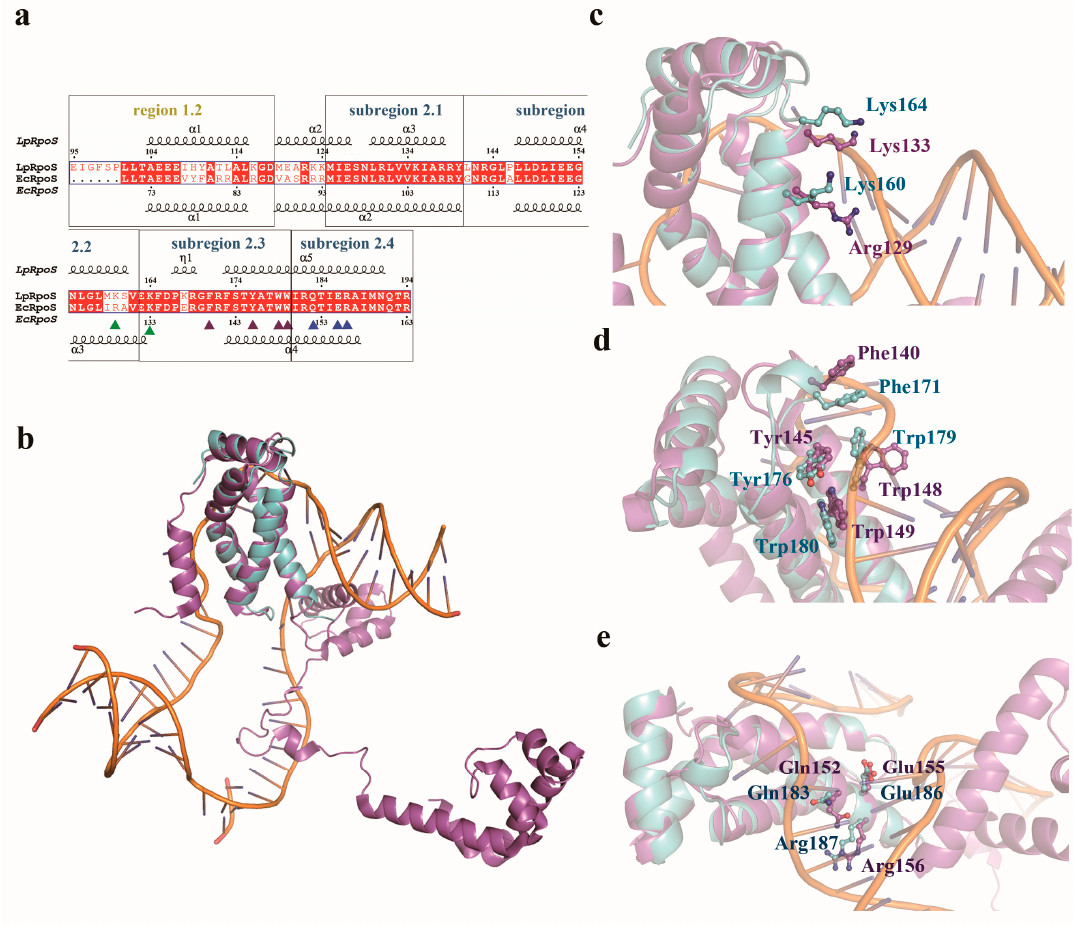
Figure 2. ( a ) Multiple alignment of Lp RpoS 95 – 195 and the corresponding region from Ec RpoS (PDB accession code 5ipl). The alignment is performed using MultAlin [11] and ESPript [12]. The secondary structural elements of Lp HGPRT and human HGPRT are separately displayed at the top and bottom of the alignment. The α -helices, 3 10 –helices, β -sheets and strict β -turns are denoted as α , η , β and TT, correspondingly. The DNA binding site, promoter melting site and the residues involved in recognizing the − 10 promoter element are marked by filled green, purple and blue triangles, respectively. The key residues from Ec RpoS (Asp87, Asp135, Pro136, and Glu137) and the corresponding residues from Lp RpoS 95–195 (Asp118, Asp166, Pro167 and Lys168) are marked in pink. ( b ) Superposition of Lp RpoS 95–195 (cyan) and full-length Ec RpoS complexed with DNA (purple) (PDB accession code 5ipl). DNA is marked in orange. ( c ) Comparison of Lp RpoS 95–195 (cyan) and Ec RpoS (purple) (PDB accession code 5ipl) structures in DNA binding site. The residues, which are involved in DNA binding site, are shown in stick form. ( d ) Comparison of Lp RpoS 95–195 (cyan) and Ec RpoS (purple) (PDB accession code 5ipl) structures in promoter melting site. The residues, which are involved in promoter melting site, are shown in stick form. ( e ) Comparison of Lp RpoS 95–195 (cyan) and Ec RpoS (purple) (PDB accession code 5ipl) structures in recognizing the − 10 promoter element site. The residues, which are involved in recognizing the − 10 promoter element, are shown in stick form.